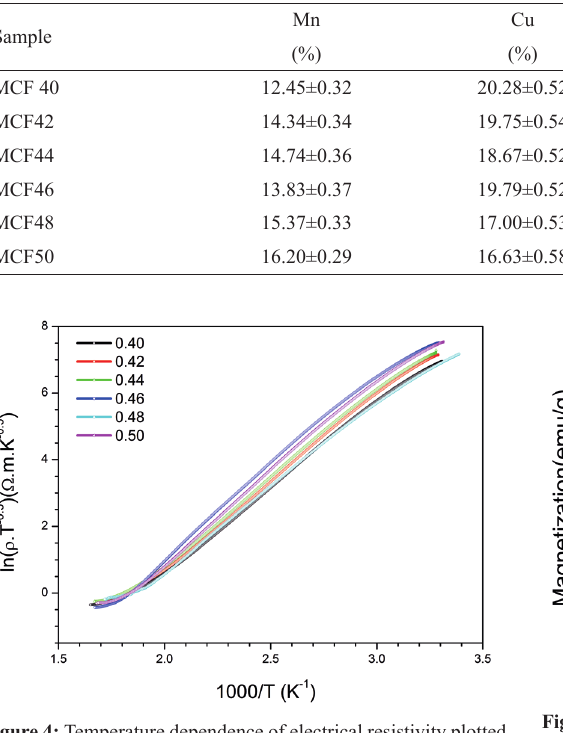
Table 1: Percentage of atomic elements of ferrites Mn